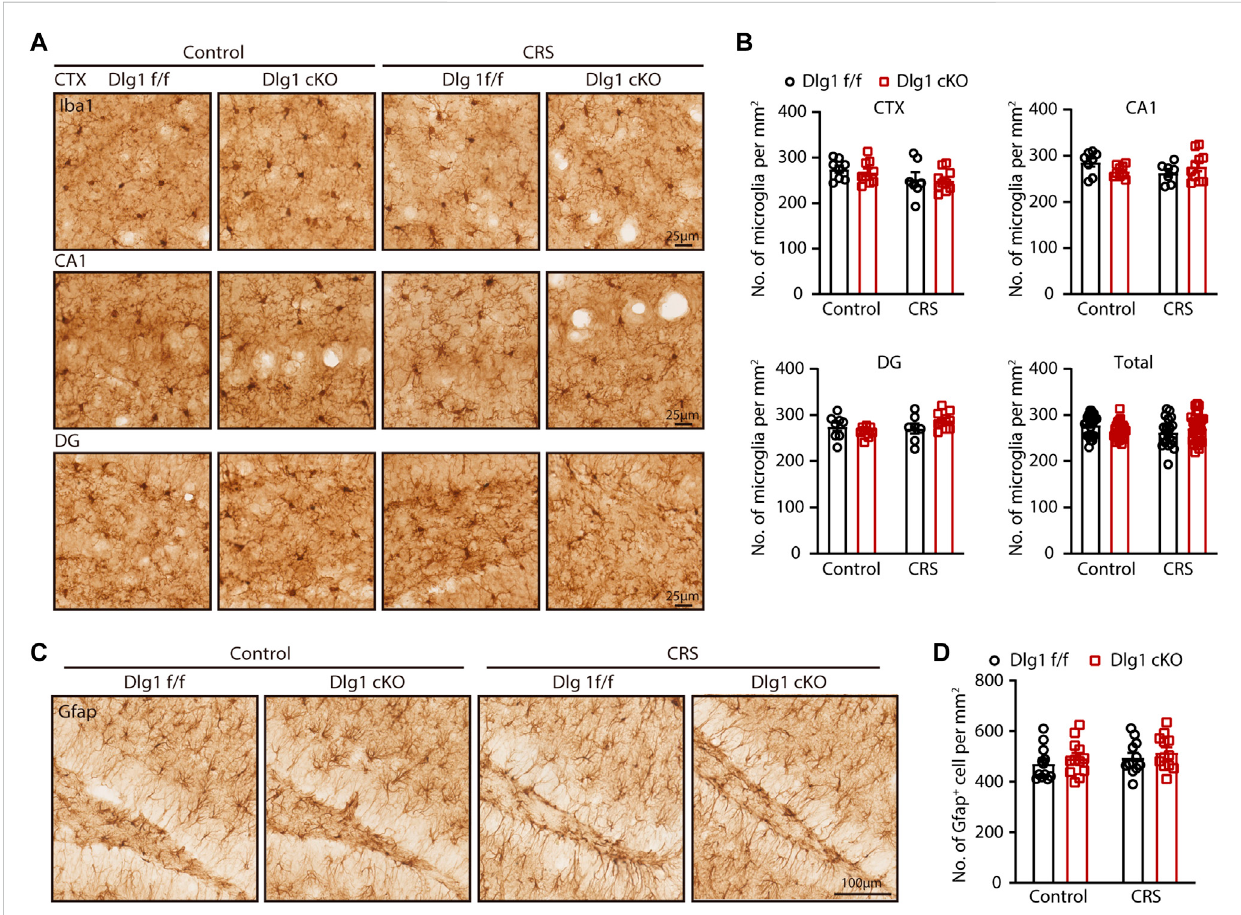
FIGURE 2 Microglial Dlg1 knockoutorCRSexposurehaslittleeffectonmicroglialdensity. (A) ImmunohistochemicalstainingforIba1(microglia)of Dlg1 f/fand cKO mice brain slices with and without CRS exposure in indicated brain regions. (Scale bars, 25 μ m) (B) Quanti fi cations of microglia density in indicated brain regions. (C) Immunohistochemical staining of Gfap (astrocytes) of Dlg1 f/f and cKO mice brain slices with and without CRS exposure in DG (hippocampus). (Scale bars, 100 μ m) (D) Quanti fi cation of astrocyte density in DG region. Data are presented as the mean ± SEM; * p < 0.05, ** p < 0.01, *** p < 0.001, two-way ANOVA with Turkey ’ s multiple comparisons